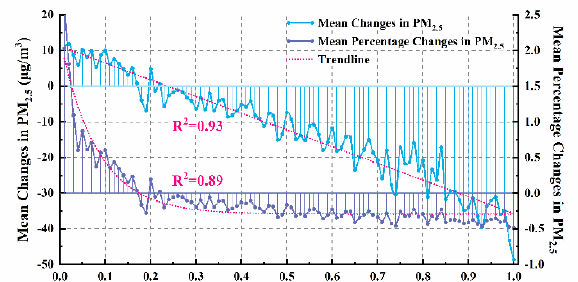
Figure 6. Changes in PM 2.5 exposure between 2010 and 2019 for each percentile bin in